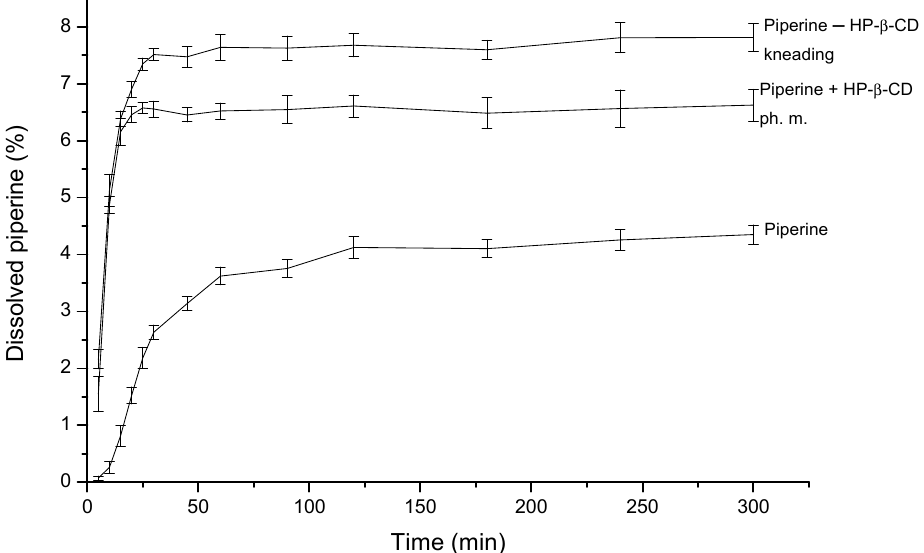
Figure 7. Apparent solubility of piperine, the mixture with HP- β -CD obtained by kneading method and physical mixture.